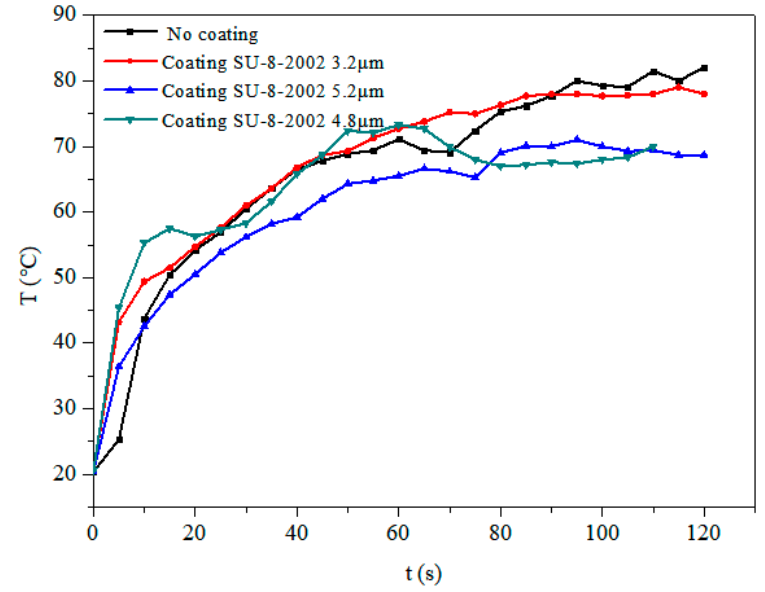
ff erent coating